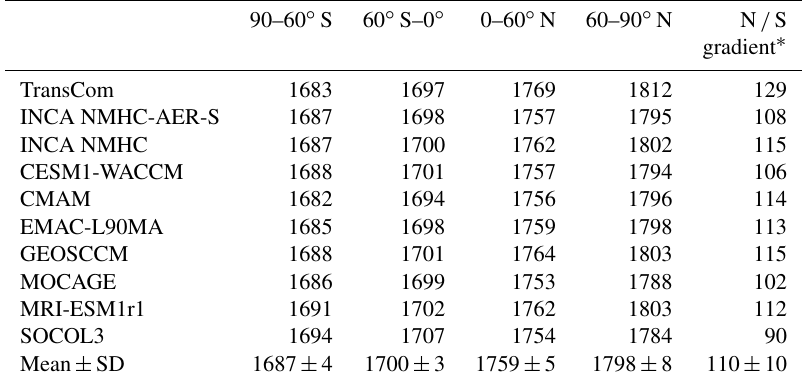
Table 7. LMDz-simulated CH 4 mixing ratios (ppbv) averaged over each latitudinal band and the years 2000 to 2010 from the standard experiment (Run_standard) using different OH fields. Multi-model means and standard deviations (mean ± SD) are also